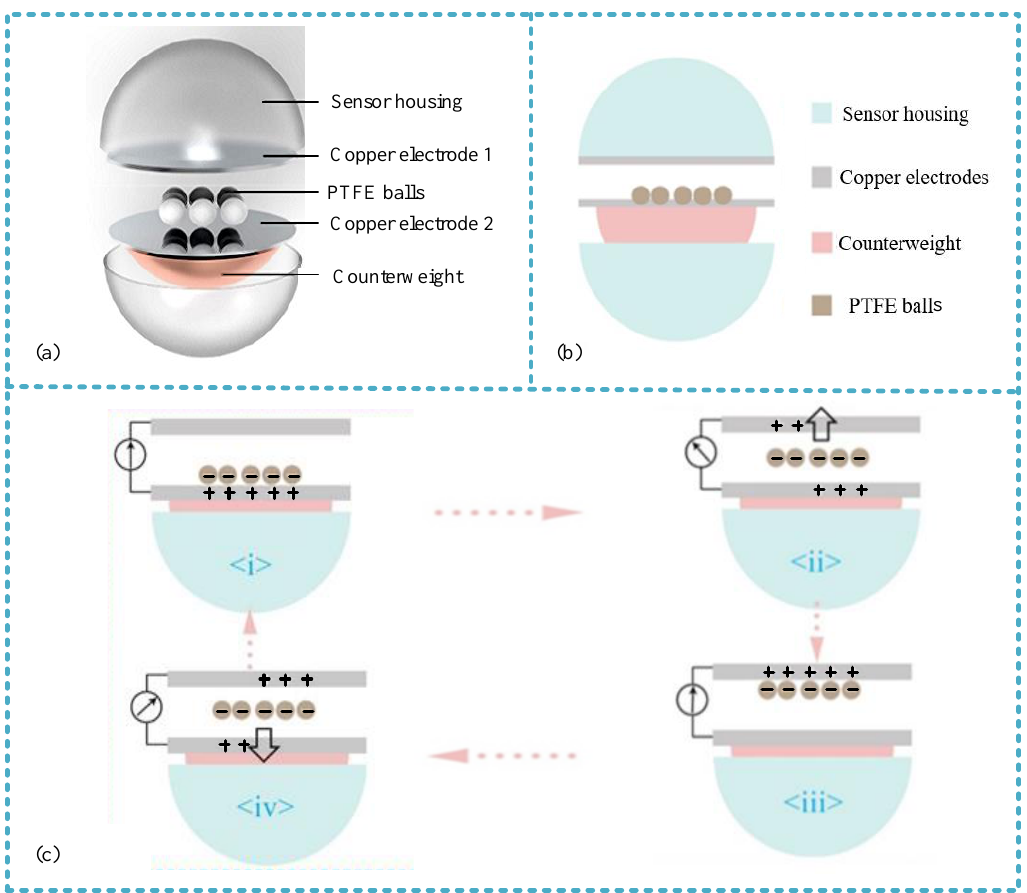
Figure 1. Internal structure and working principle of the RSV − TENG. ( a , b ) are the two-dimensional cross-sectional view of the ring-shaped deformable sensor; and ( c ) the working principle of the ring-shaped deformable sensor.